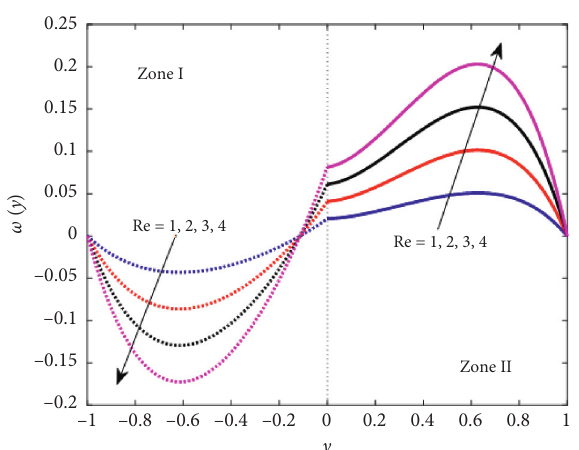
Figure 12: Microrotation profiles for various